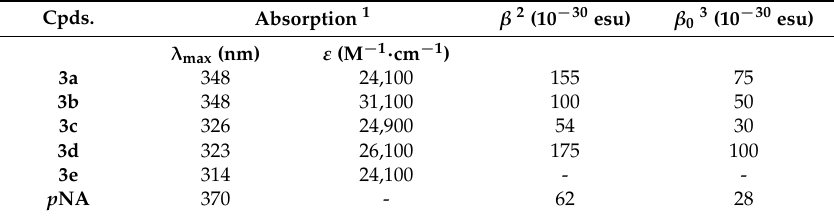
Table 2. UV-Visible absorption, β values, β 0 values for thienylpyridazines 3a – e and p -nitroaniline reference.